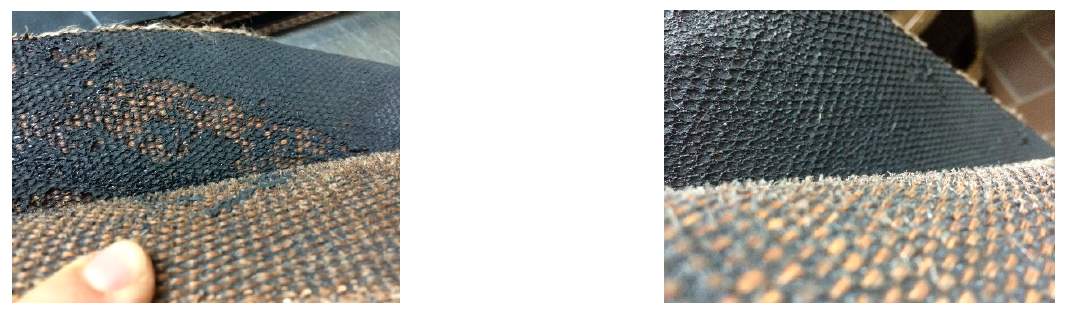
Table 3. Test results of splice